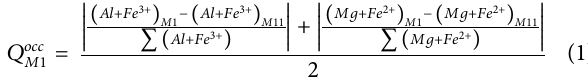
Table 1 . Fractional atomic coordinates and equivalent